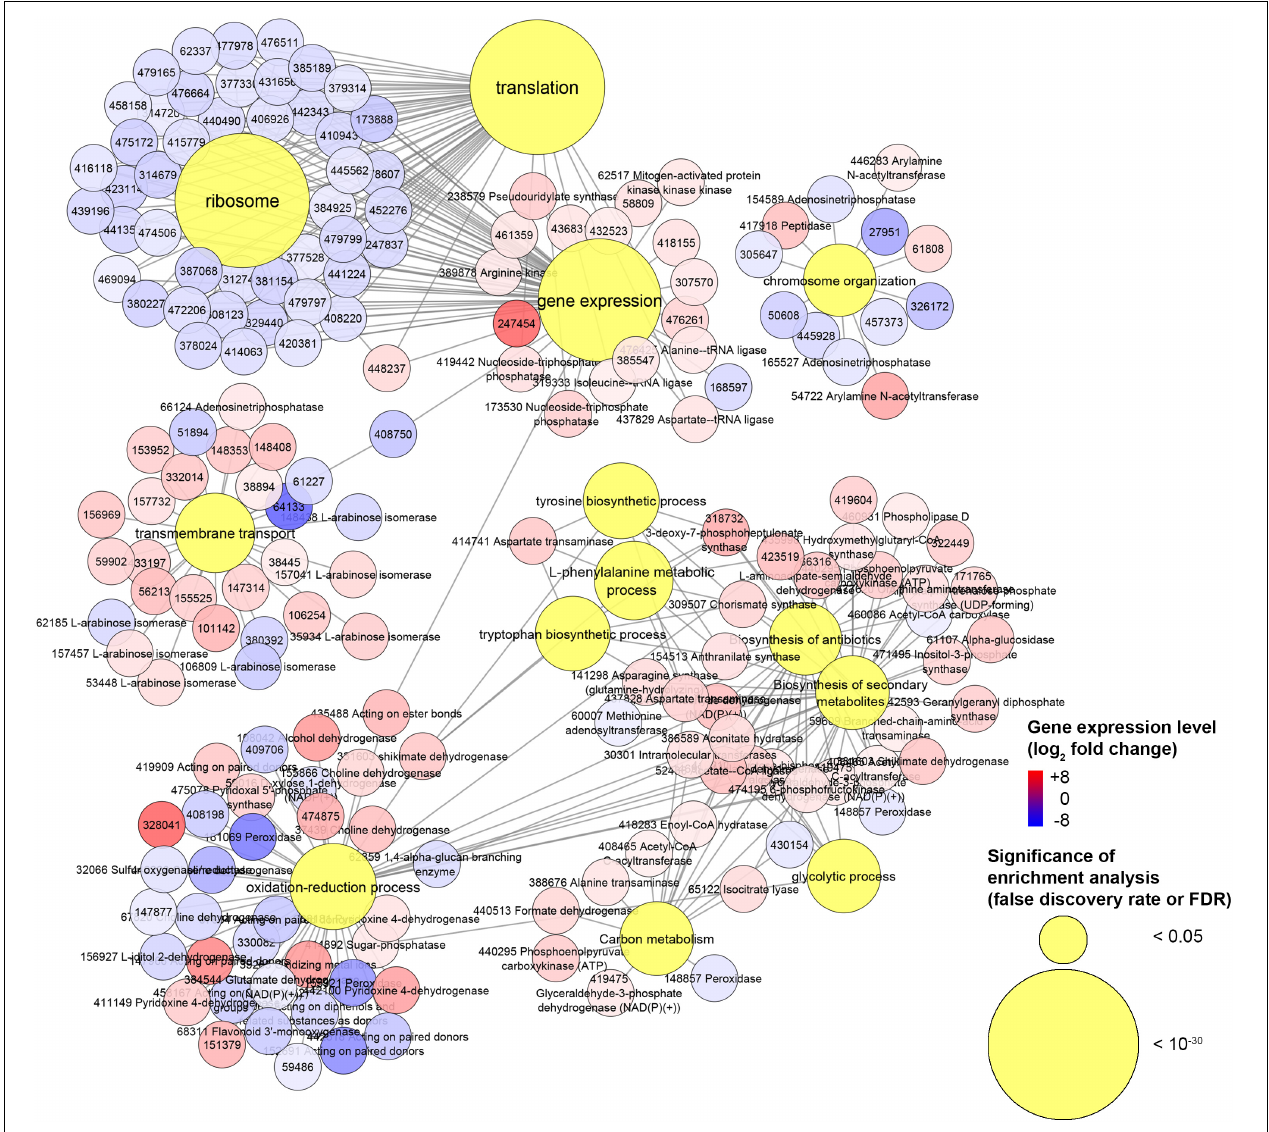
FIGURE 9 | Experiment L. Network of genes associated with gene ontologies (GOs) which were significant (false discovery rate or FDR < 0.05) in the enrichment analysis. This is a subnetwork manually extracted from the network depicted in Supplementary Figure 13 to show GOs with the most contrasting gene